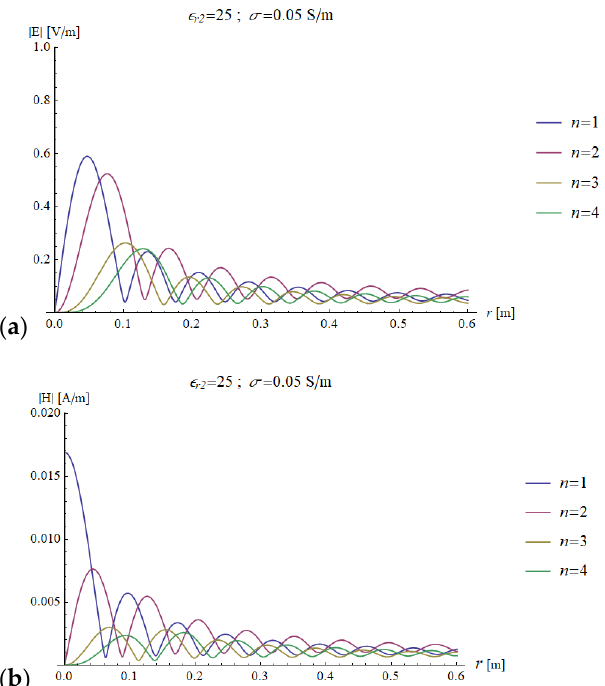
Figure 13. Electric ( a ) and magnetic ( b ) field distribution as a function of the radial coordinate for the first four modes. The sphere has a radius of 𝑎 = 0.6 m , conductivity of 0.05 S/m and a relative permittivity of 50, mimicking the electrical properties of average brain tissue at 297.2 MHz .